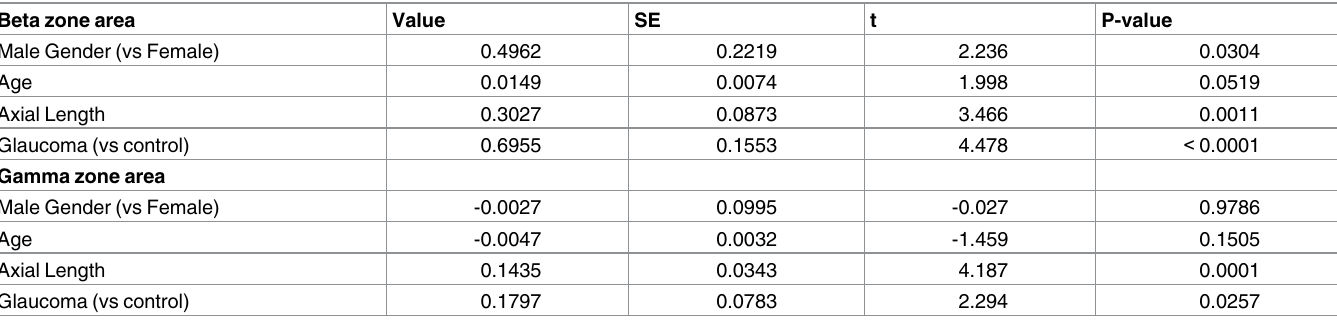
Table 2. Univariate regression analysesbetween patient characteristics and the beta zone and the gamma zone PPA area. Beta zone